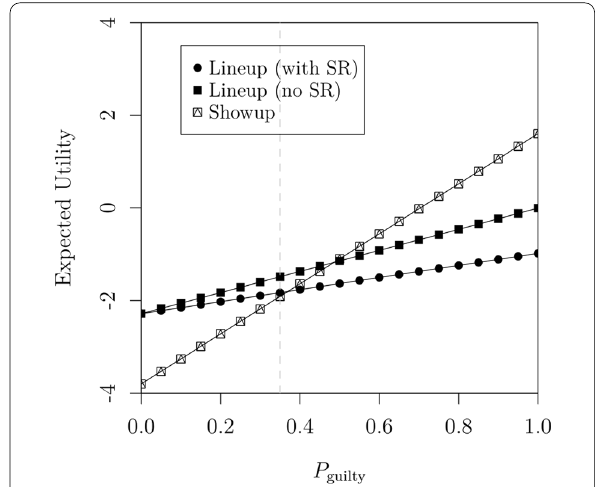
Fig. 13 Expected utilities associated with different procedures, as a function of the probability that the suspect is guilty ( P guilty ) and the outcome frequencies reported in Table 5. SR The gray dashed line corresponds to the P guilty estimate reported by Wixted et al. (2016)